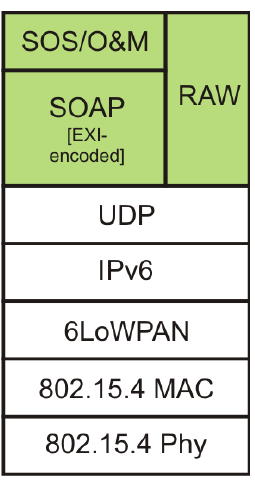
Figure 3. The complete network protocol stack used in the